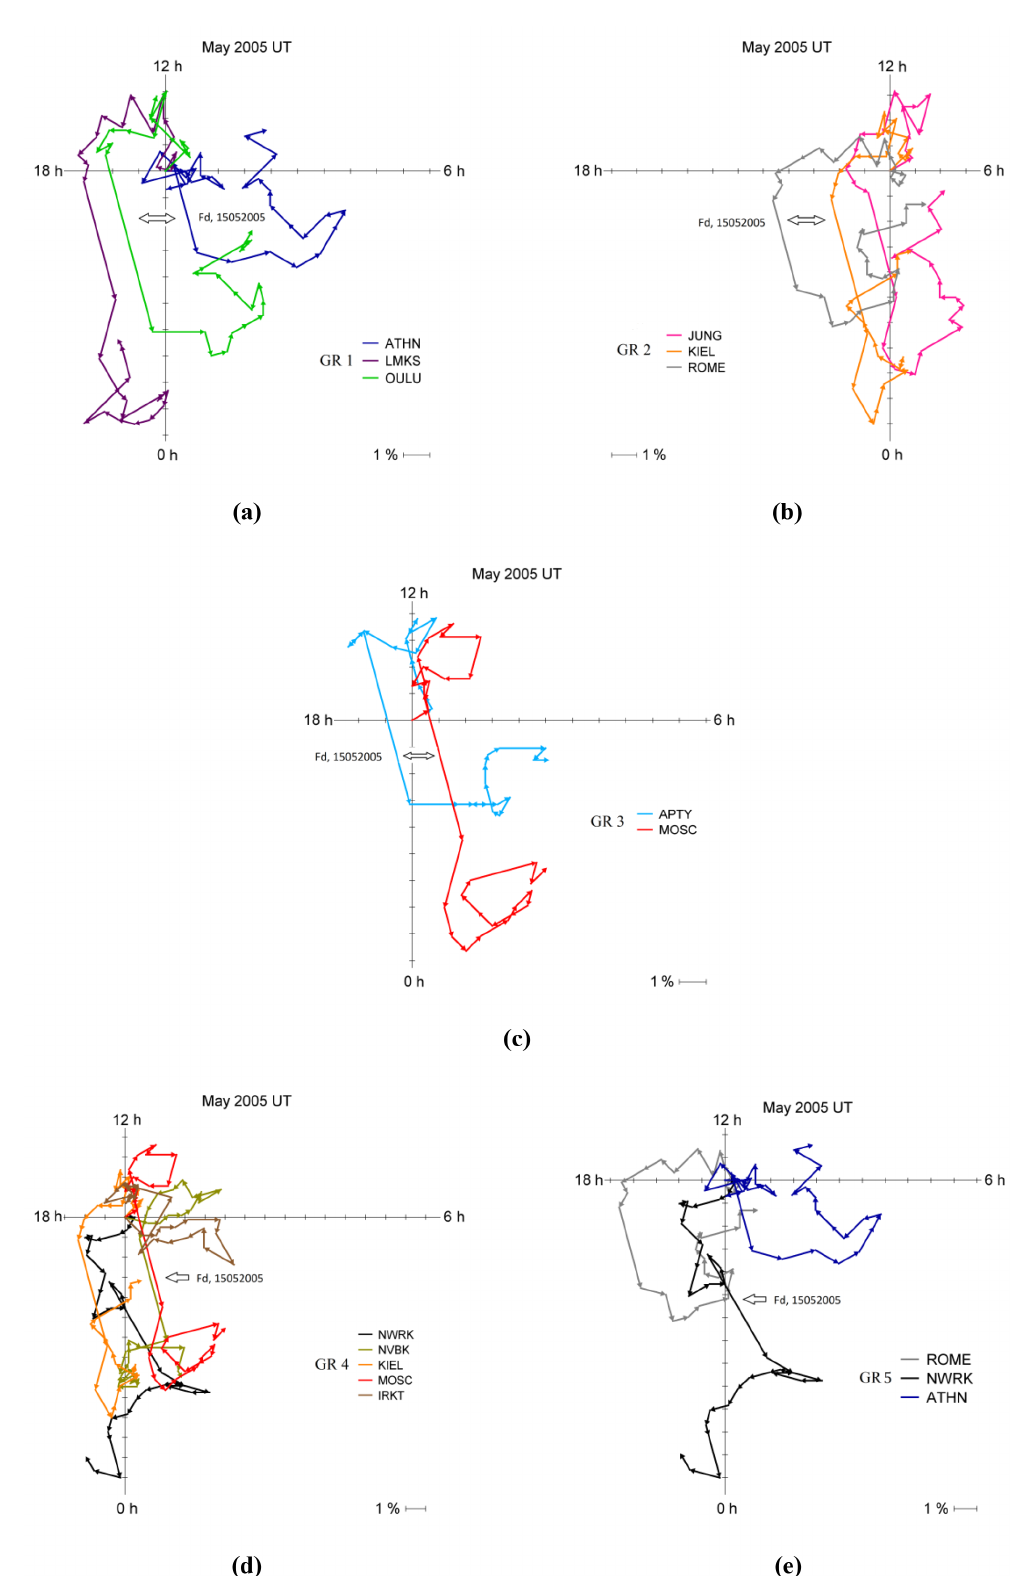
Figure 10. Daily diurnal vectors for all the groups of the stations for the month May